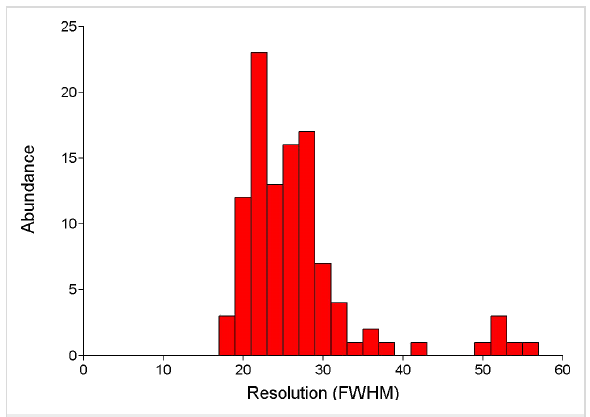
Figure 5: Histogram of the FWHM of fluorescence peaks obtained from labeled desmin filaments.